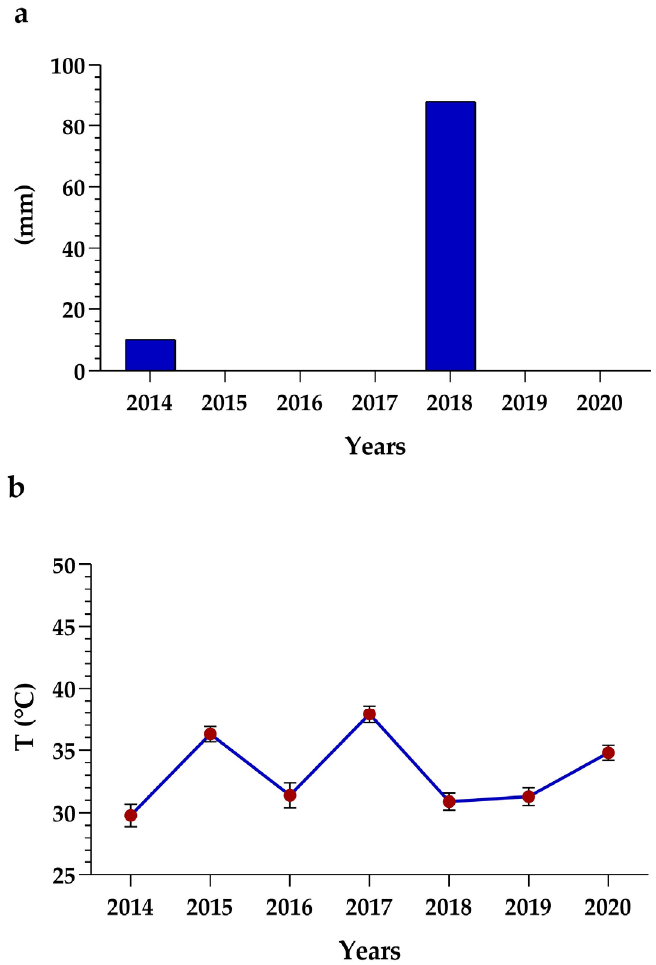
Figure 5. Meteorological data of the province of Lecce calculated for each year based on Landsat images acquired from 21 July to 11 August. ( a ) Precipitation; ( b ) Air temperature.